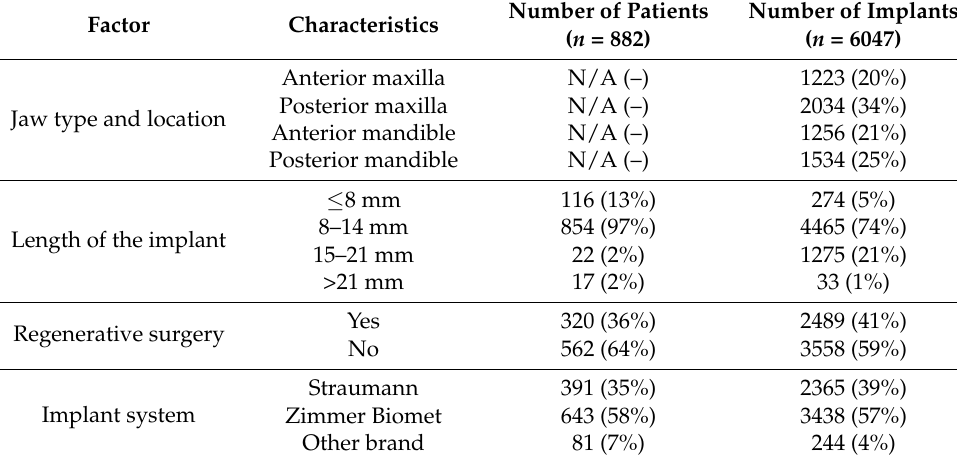
Table 3. Descriptive treatment and procedure-related characteristics. Abbreviations: SD, standard deviation; IQR, interquartile range; N/A, not applicable, i.e., calculation not suitable at the patient or implant